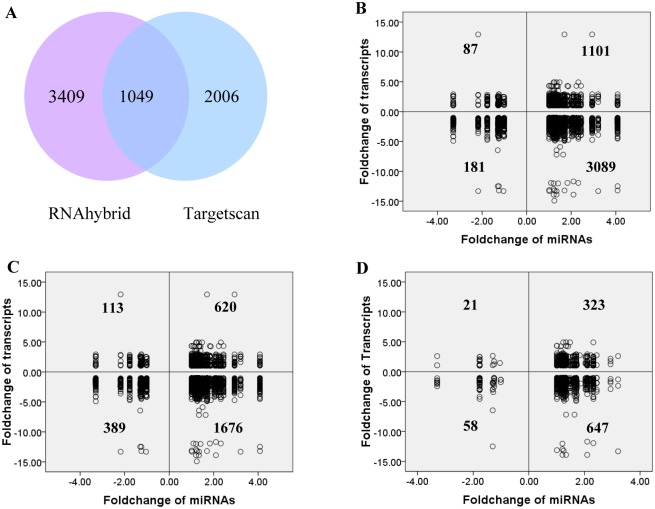
miRNA–mRNA interaction analysis by RNAhybrid and TargetScan.(A) The number of predicted miRNA–mRNA pairs by two algorithms. (B) miRNA–mRNA pair distribution in the RNAhybrid prediction. (C) miRNA–mRNA pair distribution in the TargetScan prediction. (D) The overlapping miRNA–mRNA pair distributions. The number in each quadrant represents the number of predicted miRNA–mRNA pairs. Dots in the second and fourth quadrants are negatively correlated miRNA–mRNA interaction pairs.